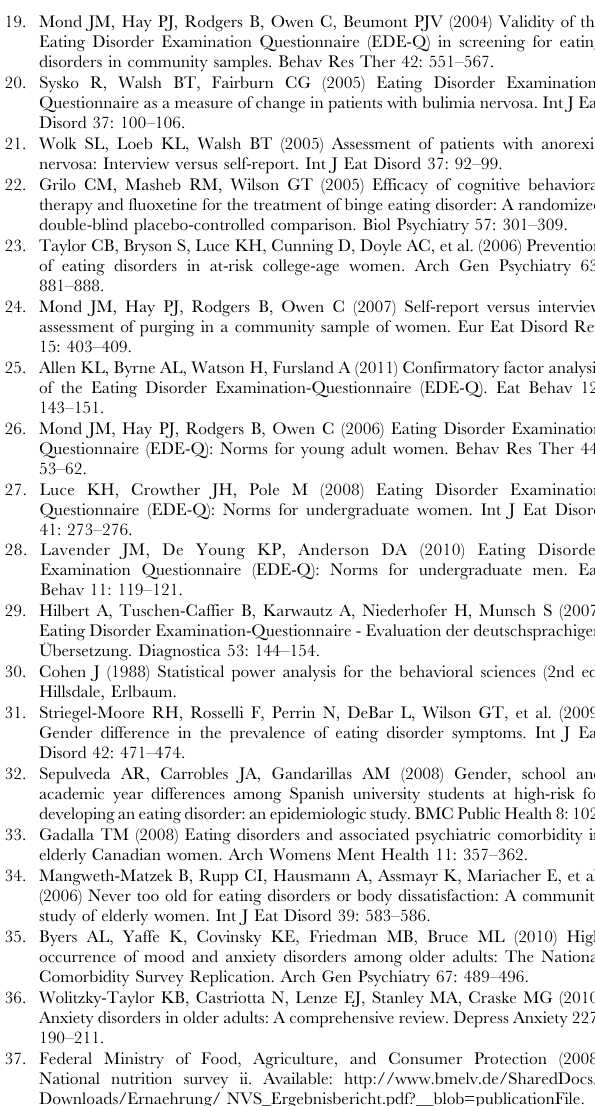
Table S1 Sex- and Age-Specific Norms of the Eating Disorder Examination-Questionnaire (N = 2520).